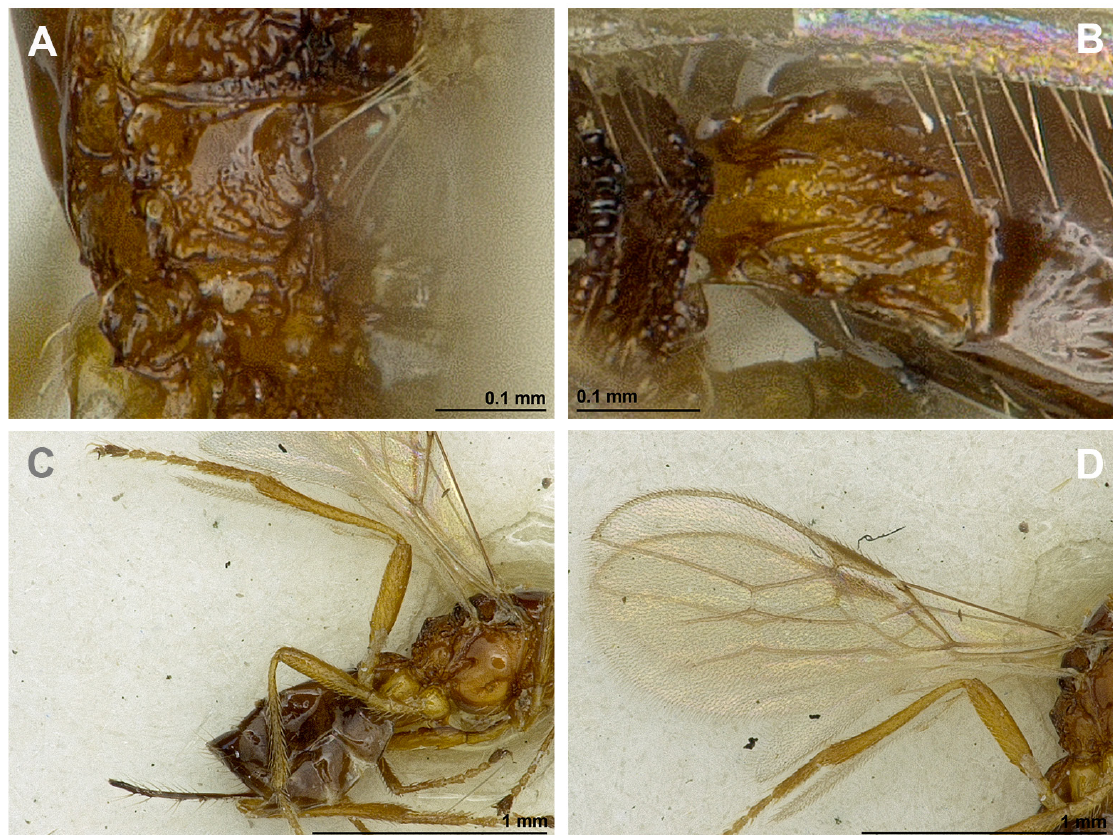
Fig. 8. Asobara carinata Peris-Felipo, sp. nov., ♀, holotype (BMNH 1922-97). A . Propodeum, dorsal view. B . First metasomal tergite, dorsal view. C . Hind leg, metasoma and ovipositor, lateral view. D . Fore and hind